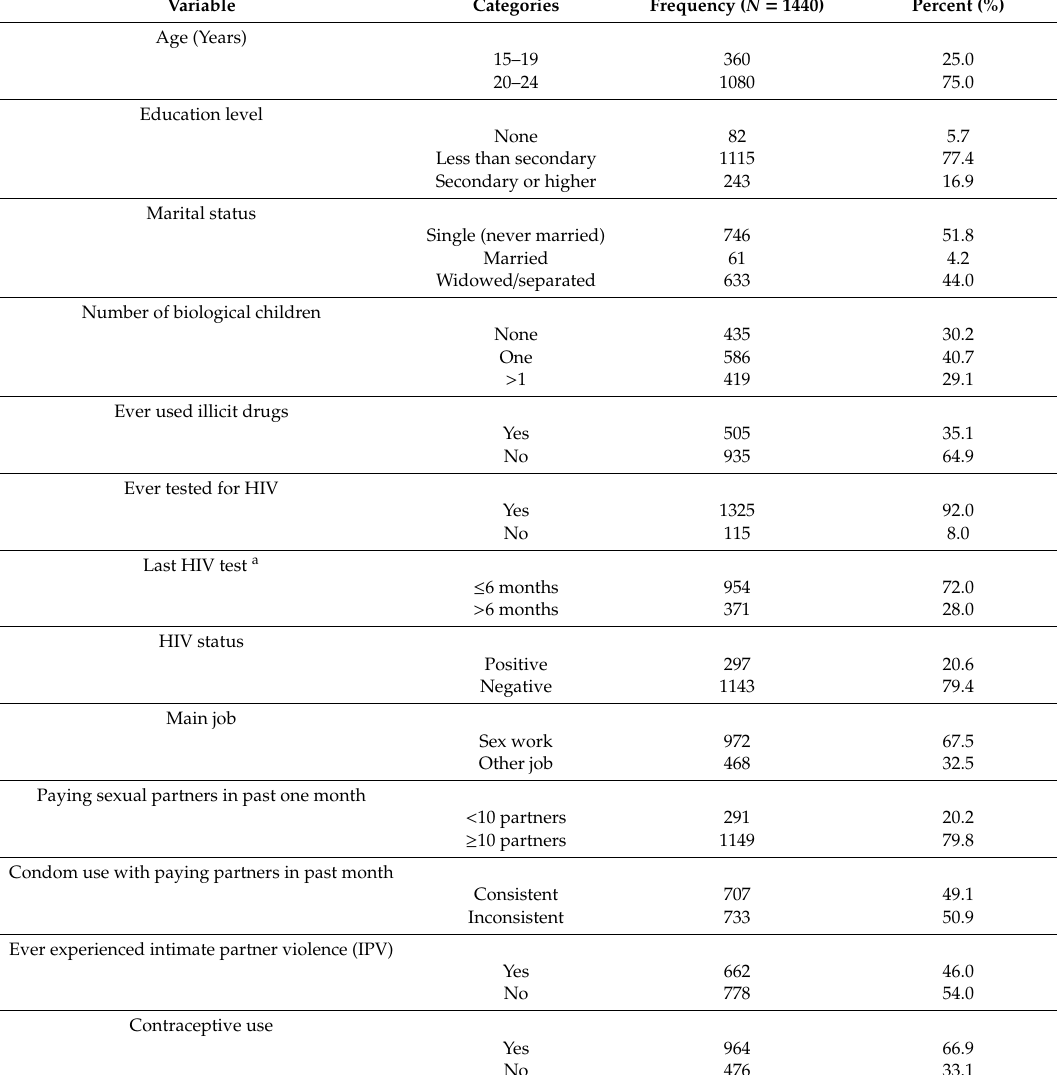
Table 1. Baseline characteristics of adolescent girls and young women (AGYW) enrolled at the Good